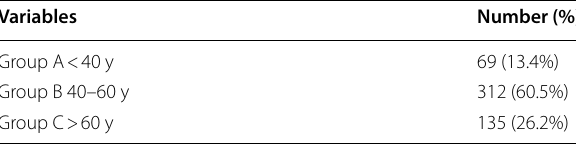
Table 1 Baseline demographic and anthropometric measures of